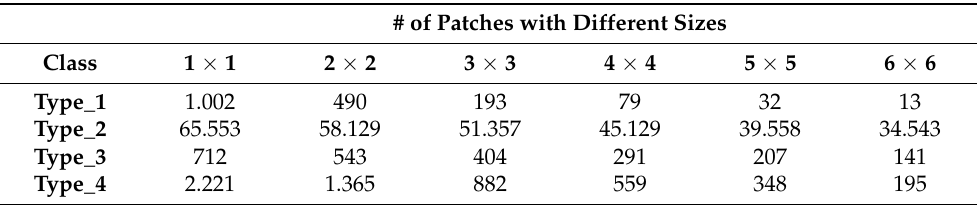
Table 4. Patches distribution as the patch size changes for the different grassland habitats. # of Patches with Different Sizes 1 ×